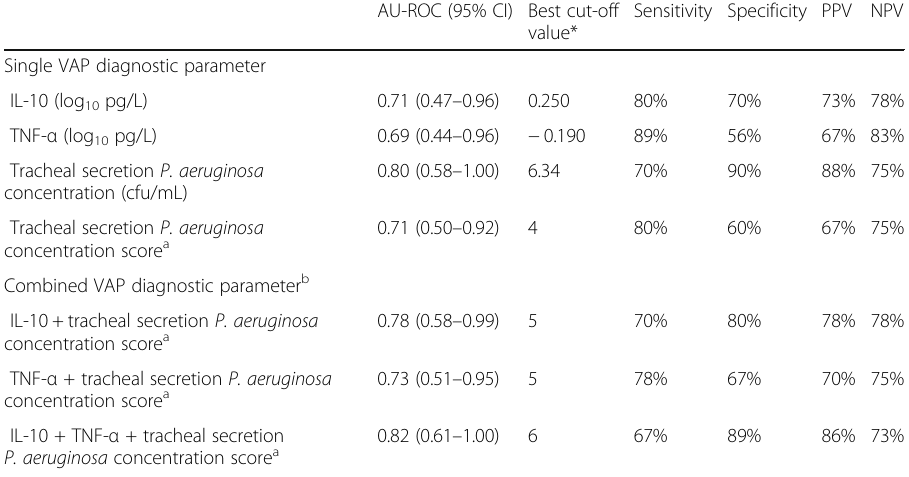
Table 6 Receiver operating curves parameters